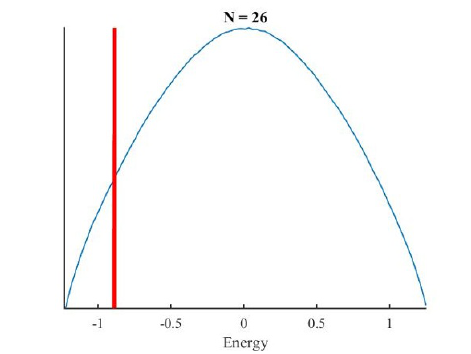
Figure 10 . Distribution of energy eigenvalues of the SYK model, the red strip shows the energy eigenstates selected for a typical